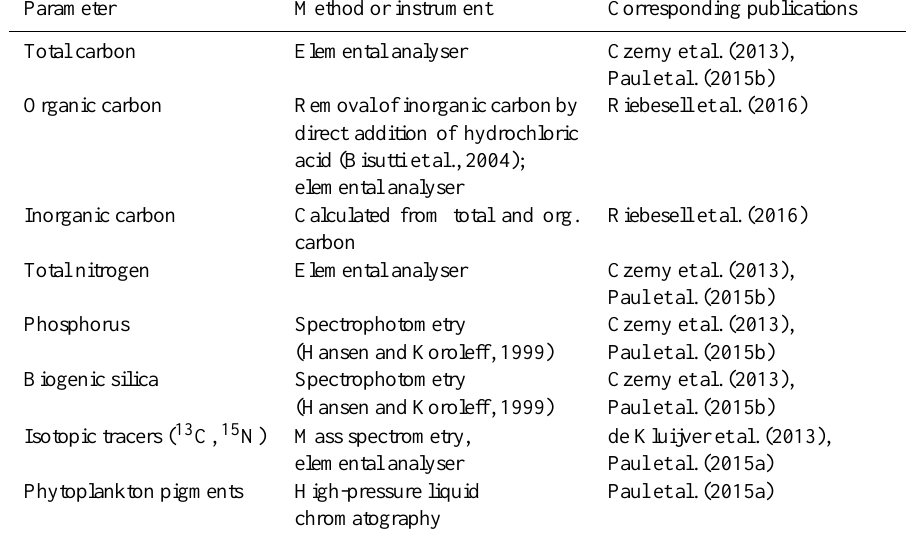
Table 3. List of parameters measured from ground sediment trap samples originating from KOSMOS experiments. The methods or instru- ments applied and the corresponding references with data sets and detailed descriptions of the methods are also